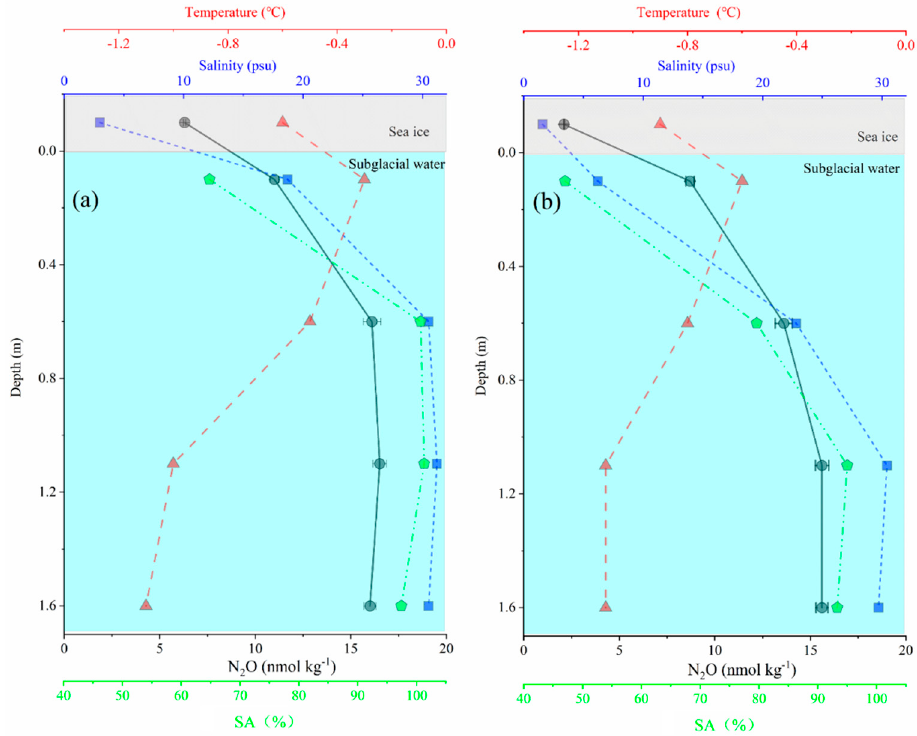
Figure 5. Temperature (red line), salinity (blue line), N 2 O concentration (gray line), and N 2 O saturation (green line) distribution versus depth in USW for ( a ) FYI and ( b ) MYI .